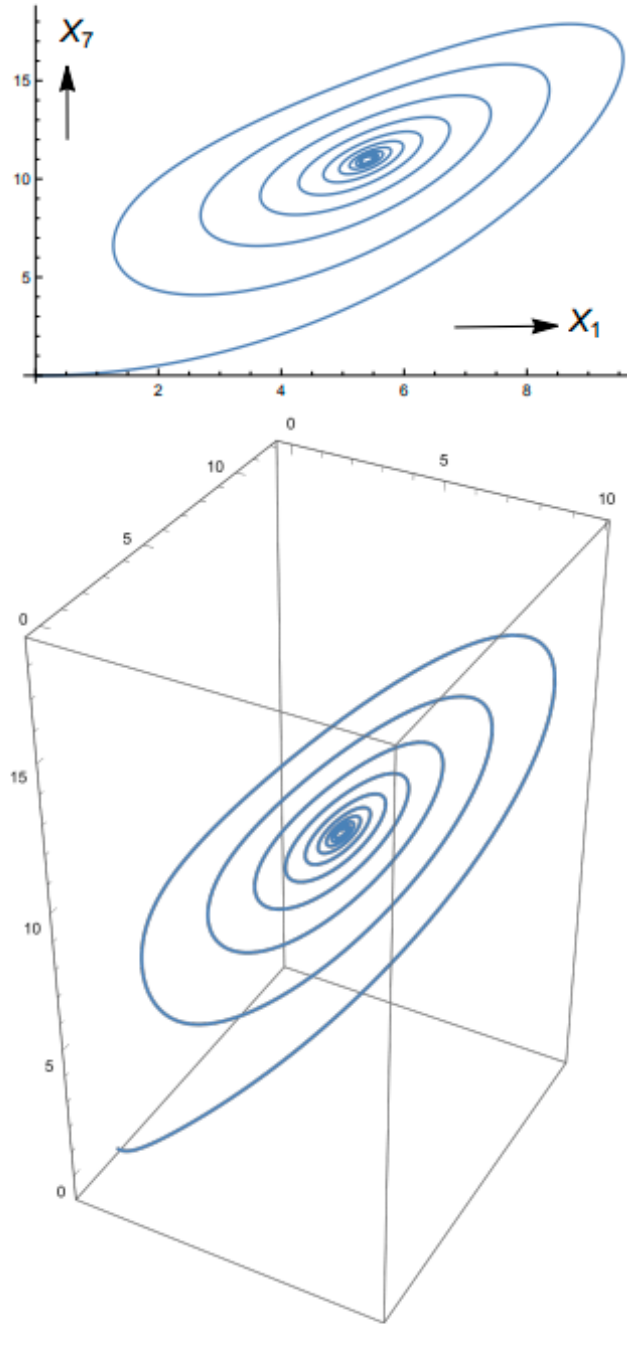
Figure 1. Phase diagrams for the nonchaotic regime with controls λ = 12, σ = 7 over time span [0, 10]: Panel 1 ( x 1 , x 4 ) , Panel 2 ( x 4 , x 7 ) , Panel 3 ( x 1 , x 7 ) , and Panel 4 ( x 1 , x 4 , x 7 ) with axes: horizontal x 1 [ 0, 10 ] , x 4 [ 0, 12 ] , x 7 [ 0, 20 ]